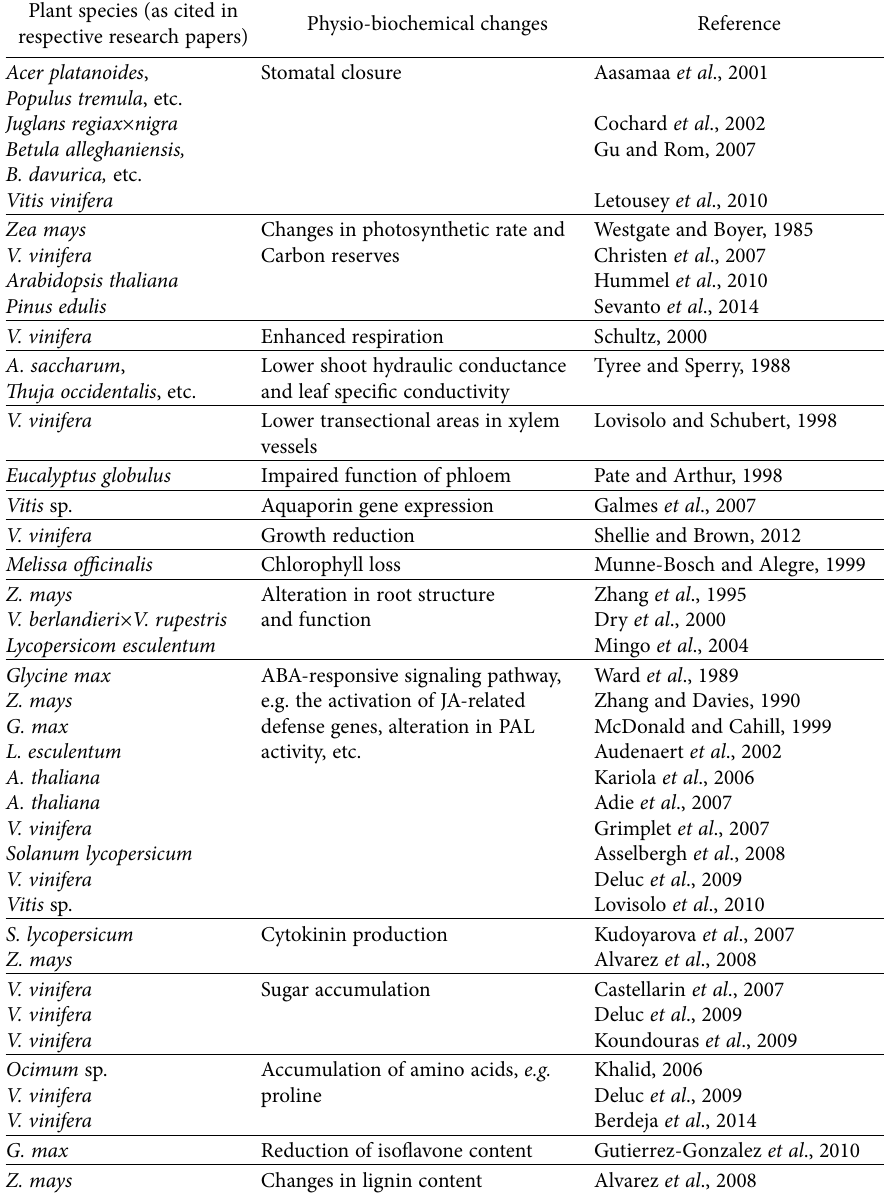
Table 2. Different plant species and their adaptive changes in response to water stress. Plant species (as cited in Physio-biochemical changes respective research papers) Acer platanoides , Populus tremula ,